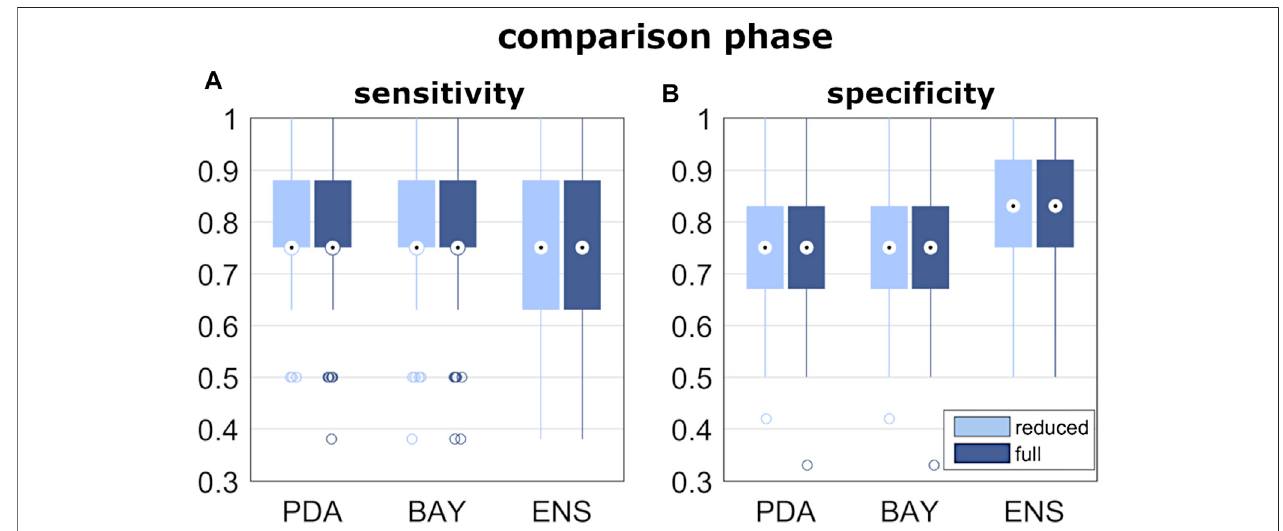
TABLE 4 | Correlation coef fi cient between geometrical and biomechanical parameters. F lat nES nMF nES along